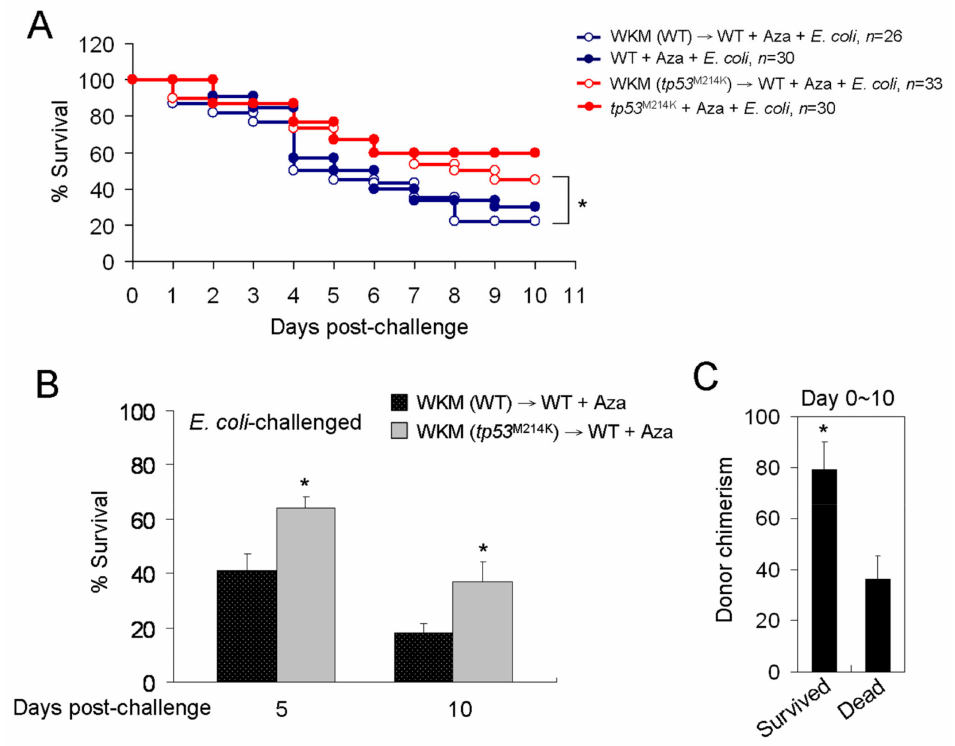
Figure 9. Prolonged survival to bacterial infection in azacitidine-treated WT zebrafish reconstituted with the tp53 M214K mutant kidney marrow. The Kaplan–Meier survival curve of azacitidine-pretreated WT, tp53 M214K mutant and their reconstituted recipients challenged with ( A ) E. coli (10 7 CFU), analyzed by the Kaplan–Meier log rank test; * p < 0.05. The Day-5 and Day-10 survival rates are shown as mean ± SD of three independent experiments in ( B ); * p < 0.05, vs. WT WKM-reconstituted zebrafish. ( C ) The donor chimerism was determined by tp53 genotyping of the tp53 M214K -reconstituted WKM from survived and dead animals till Day 10. Results are mean ± SD of three independent